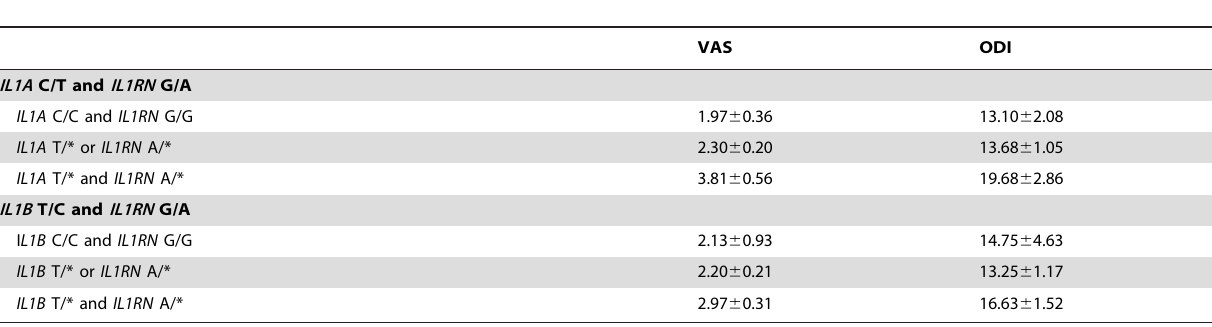
Table 3. Pain- and disability ratings at 12 months.